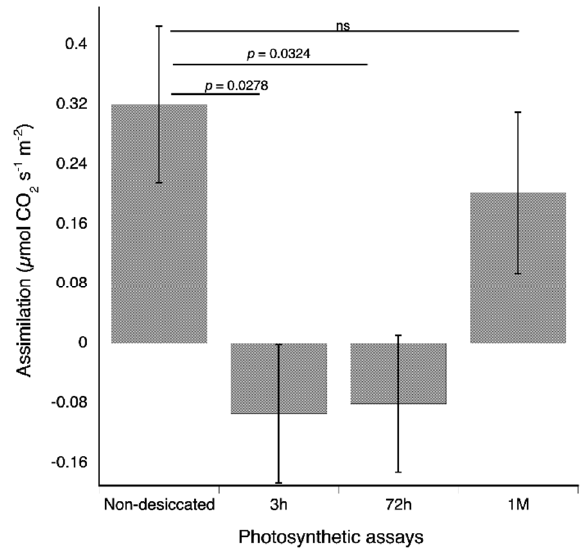
Figure 5. Non-desiccated Plagiochila porelloides plants have higher net carbon gain than plants rehydrated for three hours and 72 h but not for one month (M). Net carbon assimilation was evaluated through photosynthetic assays in three treatment groups (G1—seven sets of non-desiccated plants, G2—three sets of desiccated plants, measured three hours after rehydration, and G3—three sets of desiccated plants measured three days (72 h) after rehydration. G2 and G3 were again measured one month after rehydration. The bars indicate standard errors.